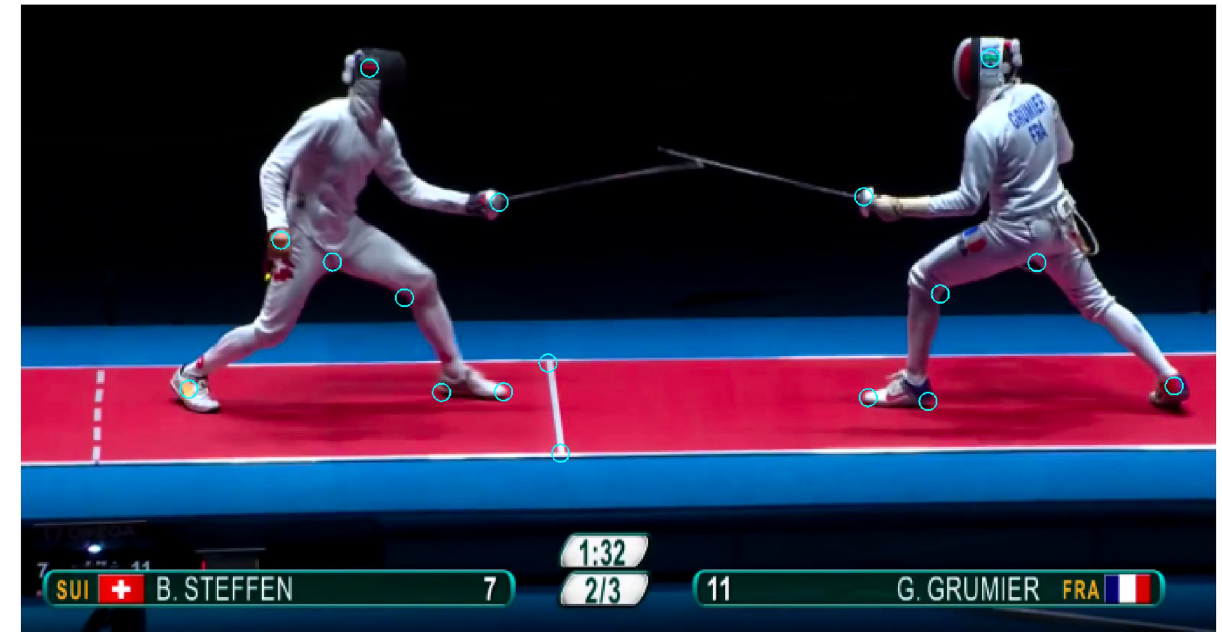
Fig 1. A duel at the Olympic games 2016. Left: Steffen (Swiss). Right: Grumier (France). The blue markers represent the points of interest captured by video tracking. Source of the original video: [6].